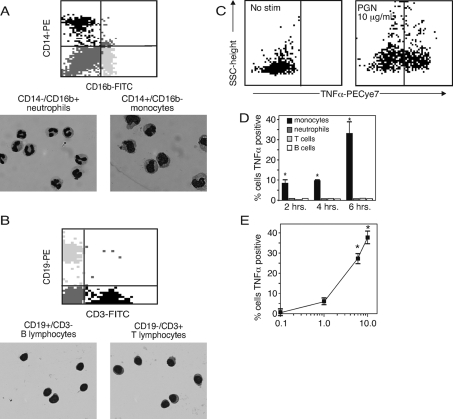
Monocytes produce TNFα in response to PGN.(A) Blood cells were sorted by SSC/FSC properties and staining intensity of fluorescent surface markers CD14, CD16b, CD3, CD19. Cells were separated as CD14+/CD16b− (monocytes), CD14−/CD16b+ (neutrophils) (A), CD19+ (B lymphocytes), CD3+ (T lymphocytes) (B). Slides were prepared of the sorted subpopulations. Leukocyte type was determined based on nuclear and cytoplasmic stain and morphology. (C) TNFα positive cells were identified using surface markers as above, in combination with intracellular staining for TNFα. (D) PB was stimulated with PGN (10 µg/ml) for 2, 4 and 6 hours. Cell populations were identified by surface markers and TNFα was measured by intracellular staining and flow cytometry. Two separate preparations from two donors were used; for the 6 hour point, five preparations were used. (E) PB was stimulated with PGN and the percent TNFα+monocytes (CD14+/CD16b−) was measured after 6 hours at each dose by intracellular staining and flow cytometry. Three separate preparations from two donors were used. For PGN (10 µg/ml), five preparations were used. The data for panel D and E are expressed as the mean±SEM. Statistical significance was determined by ANOVA with Bonferroni post test. *, p<0.001 versus 0 PGN.